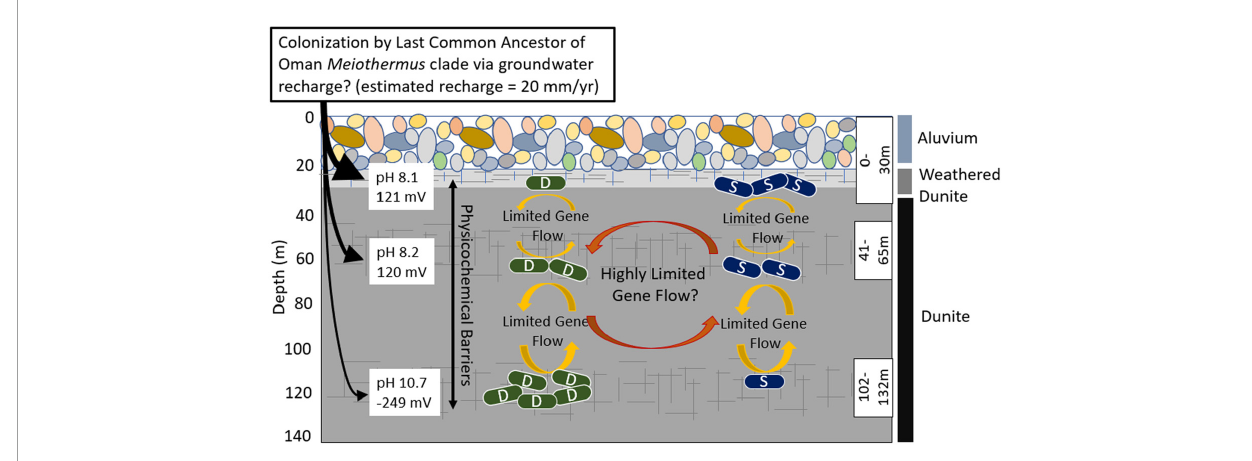
FIGURE4 Schematic depicting proposed evolutionary dynamics of the Type I surface (S) populations and the Type II deep (D) populations of Meiothermus in three discrete depth intervals (fractures, indicated by hashed lines, isolated using a down borehole packer system) in well BA1A of the Samail Ophiolite and potential gene exchange/recombination between them and selective pressures indicated by arrows and text. The number of S and D cells at each depth interval is meant to depict the relative abundance of populations belonging to each clade at that depth. Characteristics of the waters and the predominant rock types that they interact with are indicated. The evidence for highly restricted gene flow/recombination (limited number of shared SVNs) between S and D Meiothermus populations from the same depth interval could be an artifact of the binning process, as discussed in the text, and the reader is cautioned of this possibility through the use of the question mark following this statement. Single cell genomics, in combination with other physiological approaches, would provide a more robust mechanism to evaluate whether the evidence for limited gene flow/recombination is artifactual or is due to selection against hybrid